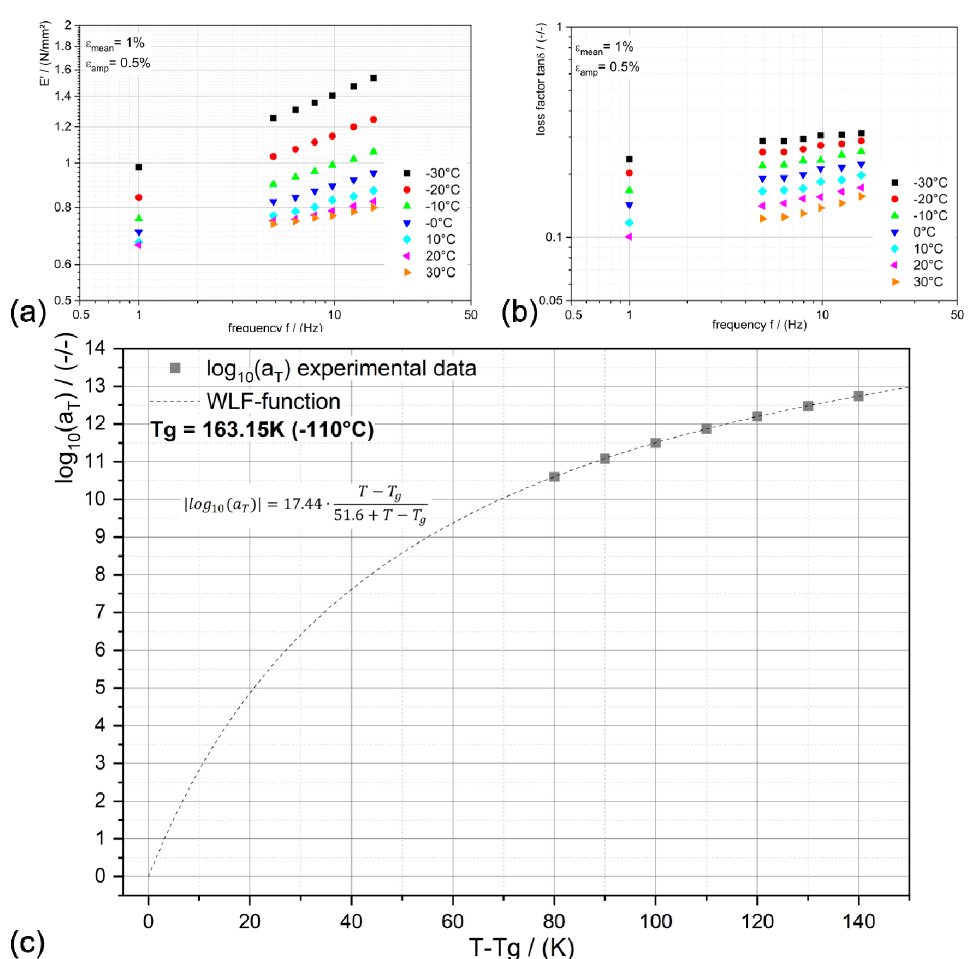
Figure 4. Panels ( a , b ) show the temperature and frequency dependent storage modulus and loss factor, respectively. In panel ( c ), the obtained time-temperature shift factors a T are presented as points and the WLF function as dashed line.